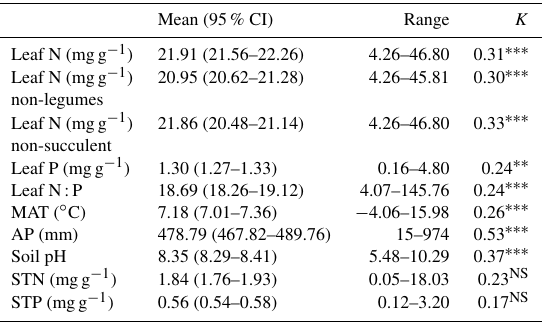
Table 1. Arithmetic mean, range, and phylogenetic signal ( K value) of leaf N and P concentrations and environmental variables for shrubs in northern